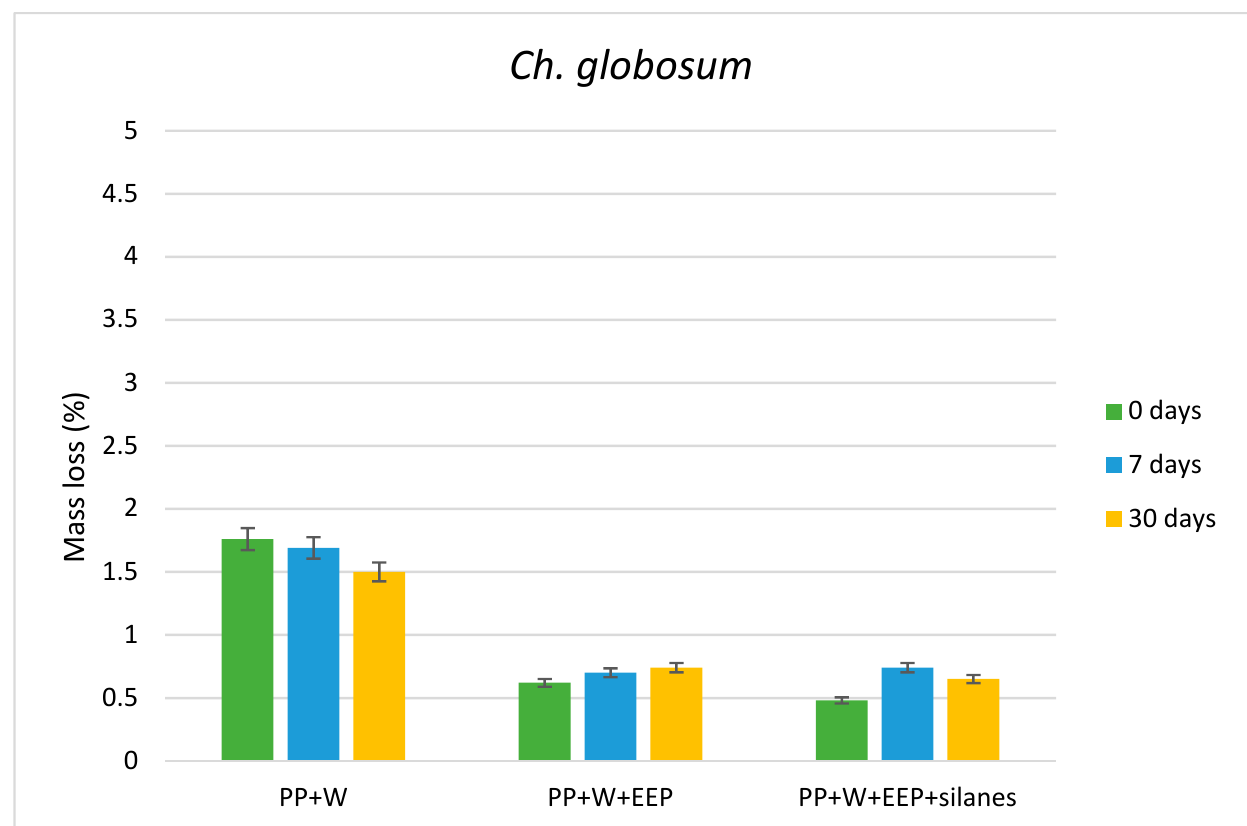
Figure 3. Mass loss of composites after exposure to C. versicolor .